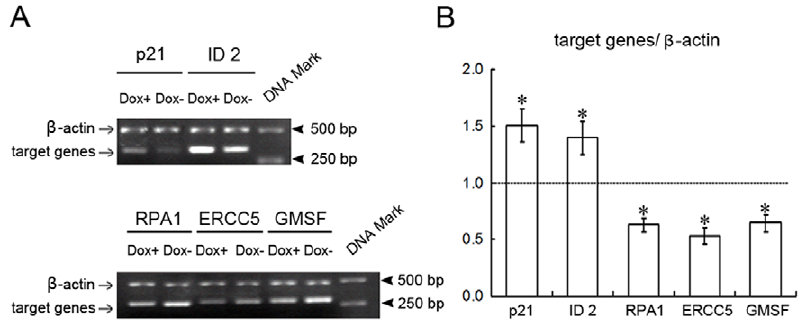
Figure 4. The semi-quantitative RT-PCR analysis of p21 cip1 , ID2, GMSF, ERCC5 and RPA1. (A) The mRNA levels of five genes, p21 cip1 , ID2, GMSF, ERCC5 , and RPA1 were selected for evaluation using semi-quantitative RT-PCR. The mRNA expression of those target genes was consistent with the hybridization data for each of the genes measured. That is, mRNA levels of p21 cip1 and ID2 were up-regulated (upper panel), while mRNA levels of RPA1, ERCC5, and GMSF were down-regulated in FN1BP1 over-expressed cells (lower panel). The statistical result of the semi-quantitative RT-PCR of the selected genes is shown in (B).